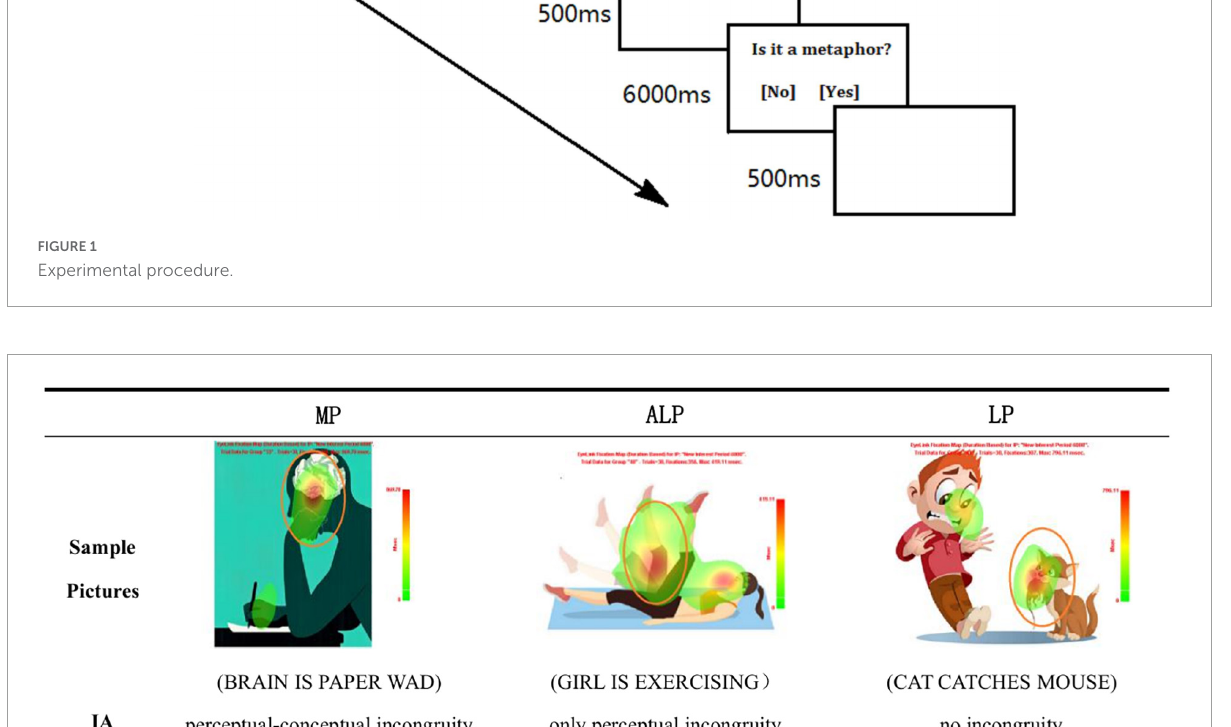
FIGURE2 Sample output Fixation Maps of the three conditions with area of interest (IA) settings illustrated